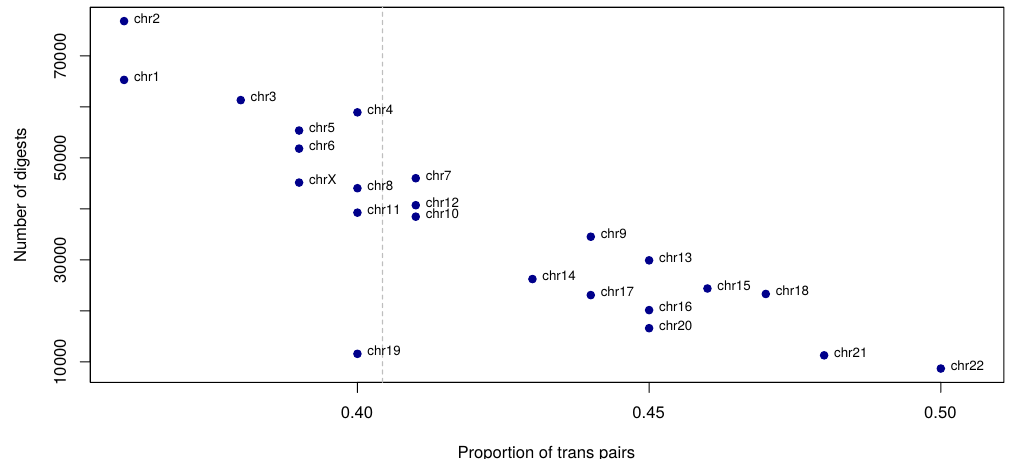
Figure 7. Proportion of trans read pairs per chromosome vs. total number of restriction digests per chromosome for a Capture Hi-C (CHC) experiment in human GM12878 cells